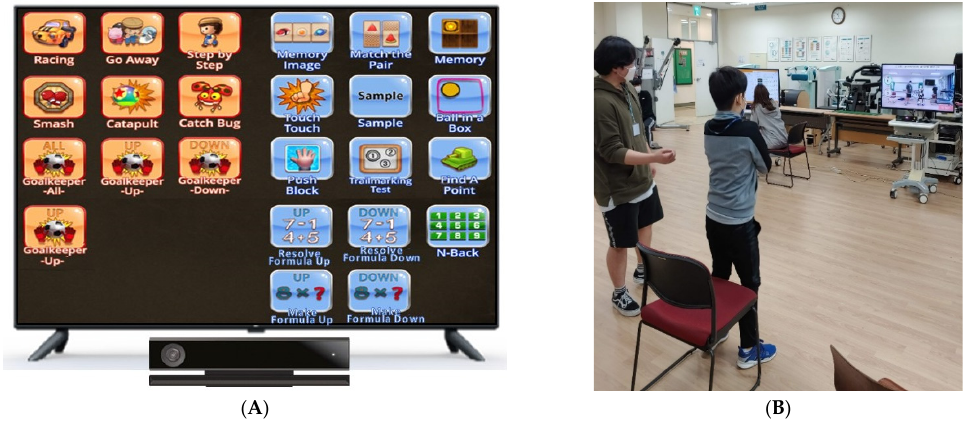
Figure 2. ( A ) Augmented reality-based rehabilitation device. ( B ) Participant during the exercise ses- sion. Table 1. Details and times of dual-task